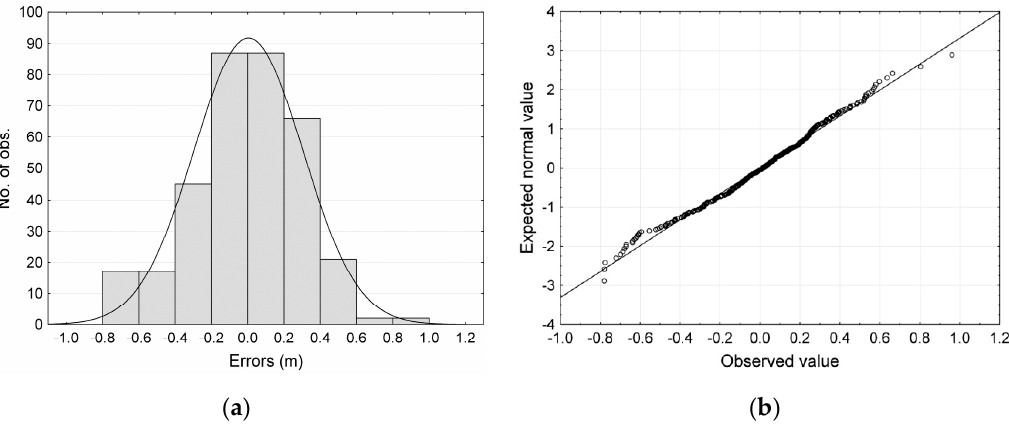
Figure 5. Histogram of the errors ∆ h in meters ( a ); and the normal Q-Q plot for the distribution of errors ( b ).